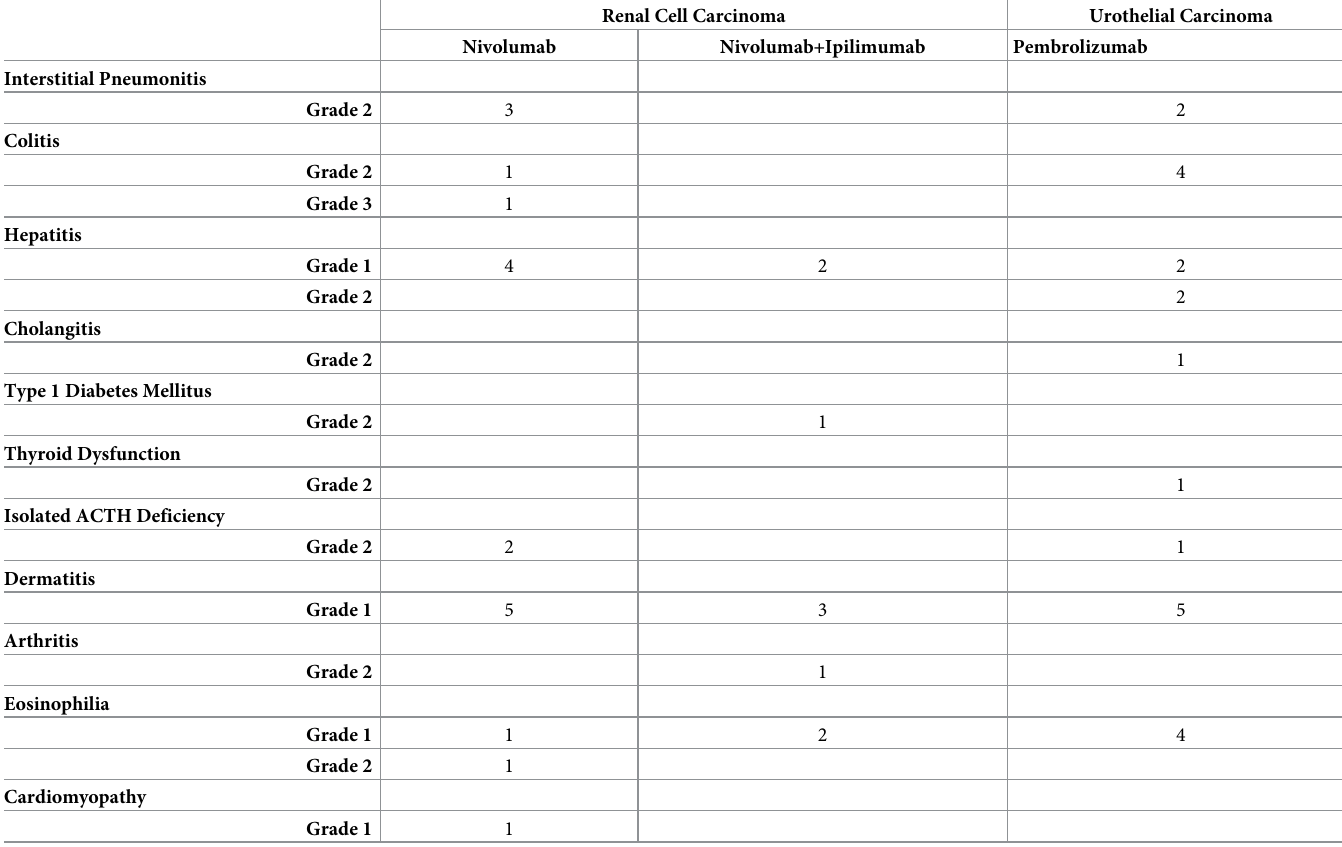
Table 4. Details of immune-related adverse